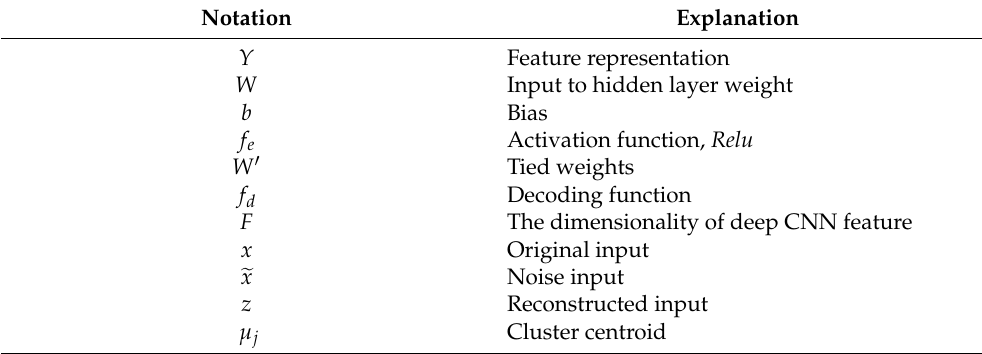
Table 1. Notations and